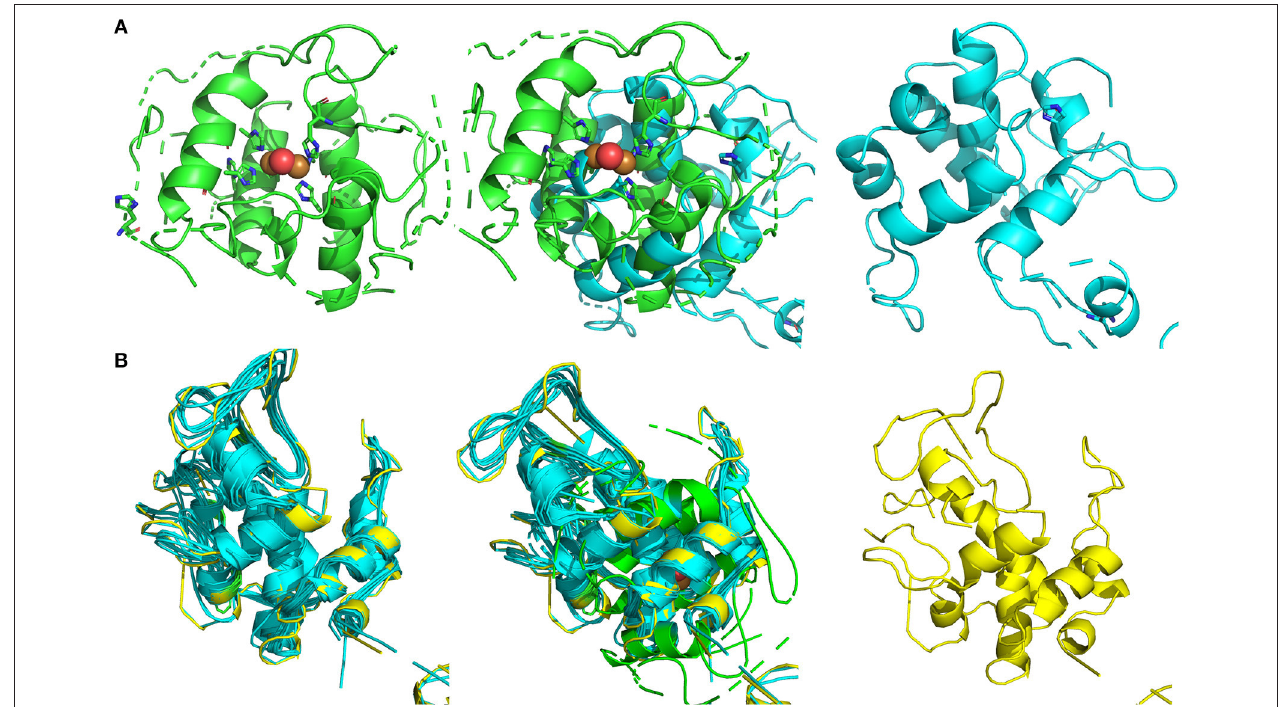
FIGURE 3 | Structural modeling and visualization of three dimension structures. (A) Green, crystal structure of sweet potatoes PPO (PDB entry: 1BT1); cyan, final predicted structure of BRP; mixture, model fitting. (B) Green, crystal structure of sweet potatoes PPO (PDB entry: 1BT1); cyan, modeling templates (top 10); yellow, final predicted structure of BRP.